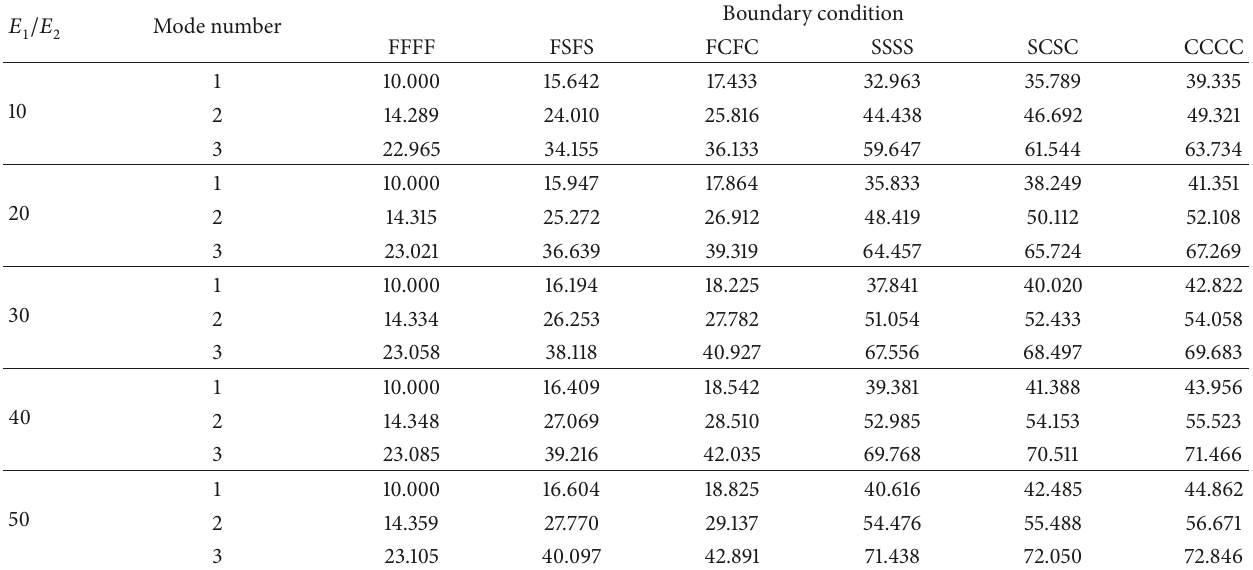
Table 4: Frequency parameters Ω for angle-ply (+45 ∘ / − 45 ∘ ) rectangular plate with different BC and anisotropic degrees. 𝐸 /𝐸 1